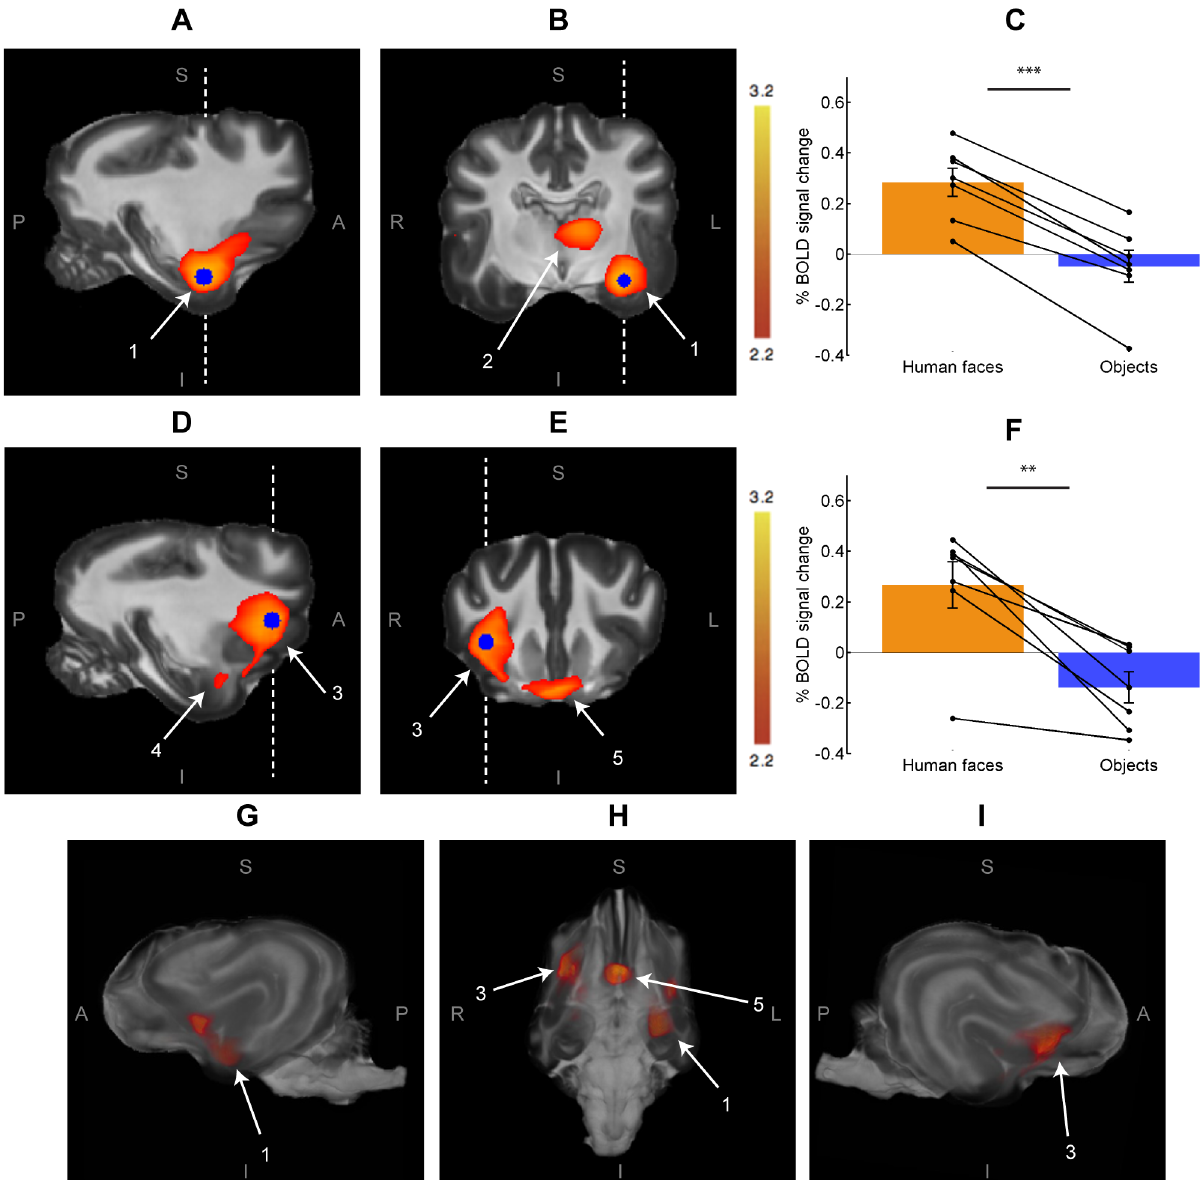
Fig 3. Human faces > Objects (n = 7). The two largest resulting clusters are shown overlaid on the Datta atlas [24]. A. Sagittal slice of the temporal cluster, which shows activity within the left temporal and frontal cortices. B. Coronal slice shows the left temporal cluster, which extends to the thalamus. C. BOLD signal change in a 5 mm of radius sphere around the voxel with maximum z value for the left temporal cluster (blue sphere in A and B). D. Sagittal slice of the frontal cluster, which is located in the right frontal temporal and cortices. E. Coronal slice of the frontal cluster. F. BOLD signal change in a 5 mm of radius sphere around the voxel with maximum z value for the right frontal cluster (blue sphere in D and E). G-I. Volume renderings of the same results, seen in left lateral, basal and right lateral views, respectively. S = Superior, I = Inferior, L = Left, R = Right, P = Posterior and, A = Anterior. 1 = Temporal Cortex, 2 = Thalamus, 3 = Lateral Frontal Cortex, 4 = Temporal Cortex, 5 = Medial Frontal Cortex. The oblique lines in C and F represent data of each participant, while vertical lines denote the standard error ( *** < 0.001, ** <